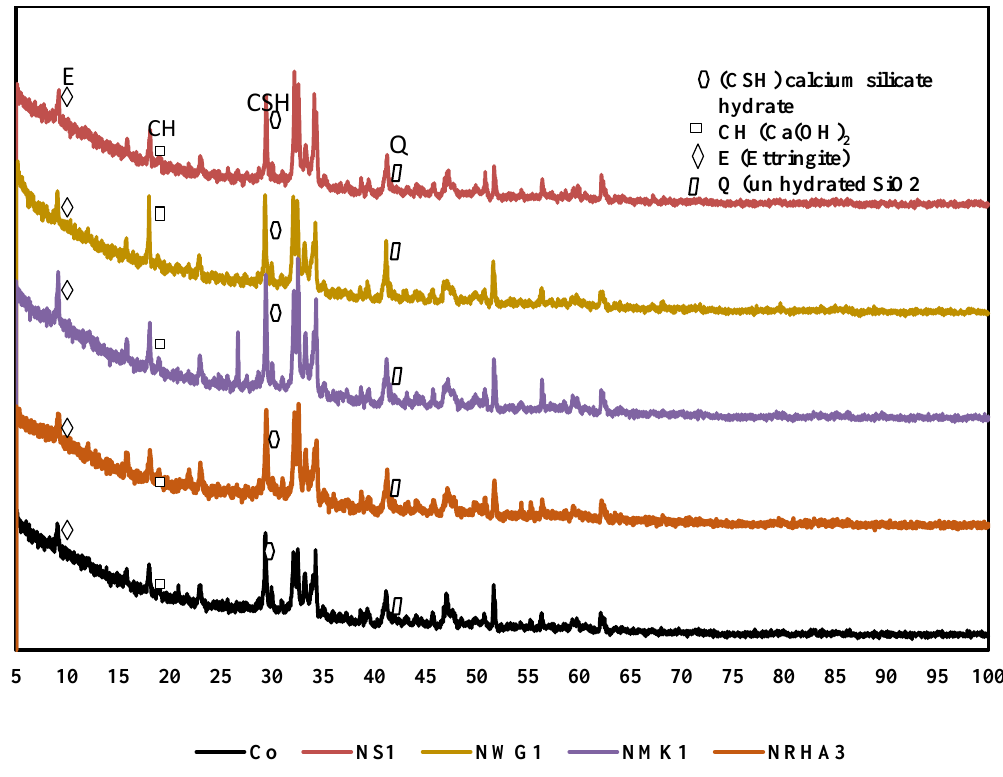
Figure 11. XRD for cement pastes with different nanomaterials.